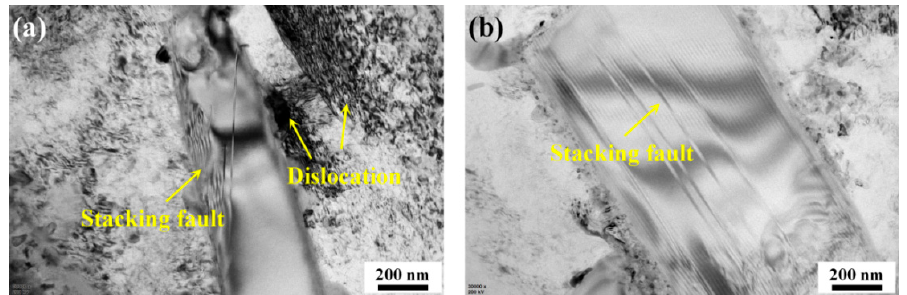
Figure 5. Typical TEM images illustrating microstructural morphology of SiC particles in the TLSPed-30 J specimen. ( a ) Stacking fault generated near the SiC/Al boundary, and ( b ) stacking fault generated inside the SiC particle.